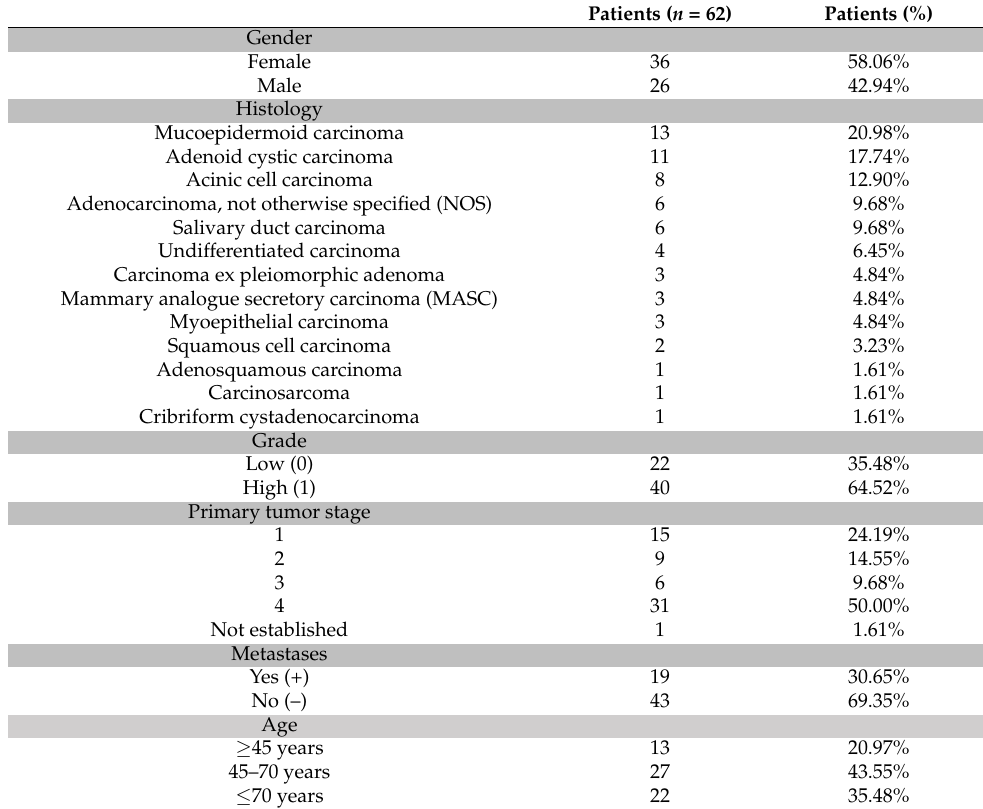
Table 1. Clinicopathological variables for the patient cohort. Shading stands for each group of variables and helps to easily locate the main